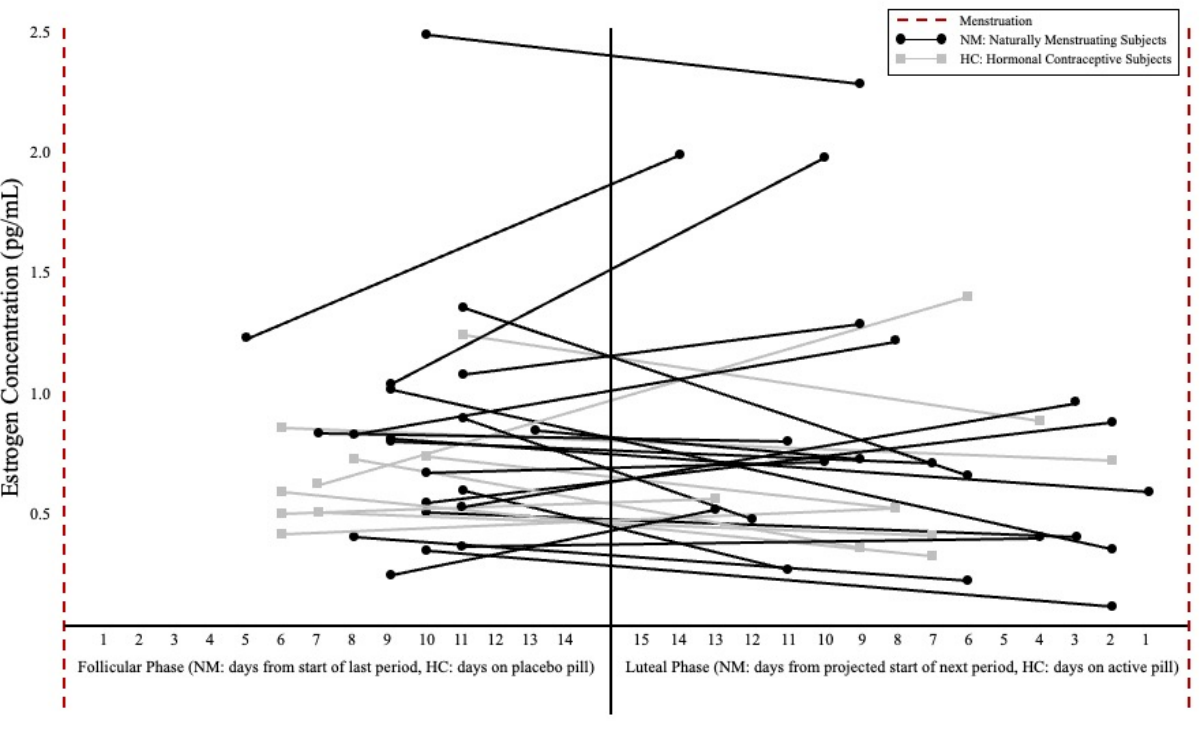
Figure 3. Estrogen concentration (pg/mL) and post-supplementation day of cycle between hormonal phases. Note: Follicular phase days were counted from the start of the subject’s last period or as days on a placebo pill for HC users. Luteal phase days were determined by number of days until the next projected period or days on the active pill for HC users. Black circles represent naturally menstruating subjects and gray boxes represent subjects using hormonal contraceptives. Connected dots indicate the spread of post-supplementation testing for individual subjects. There were no significant differences in estrogen concentration between NM and HC subjects or between hormonal phases (significance level set at ≤ 0.05).